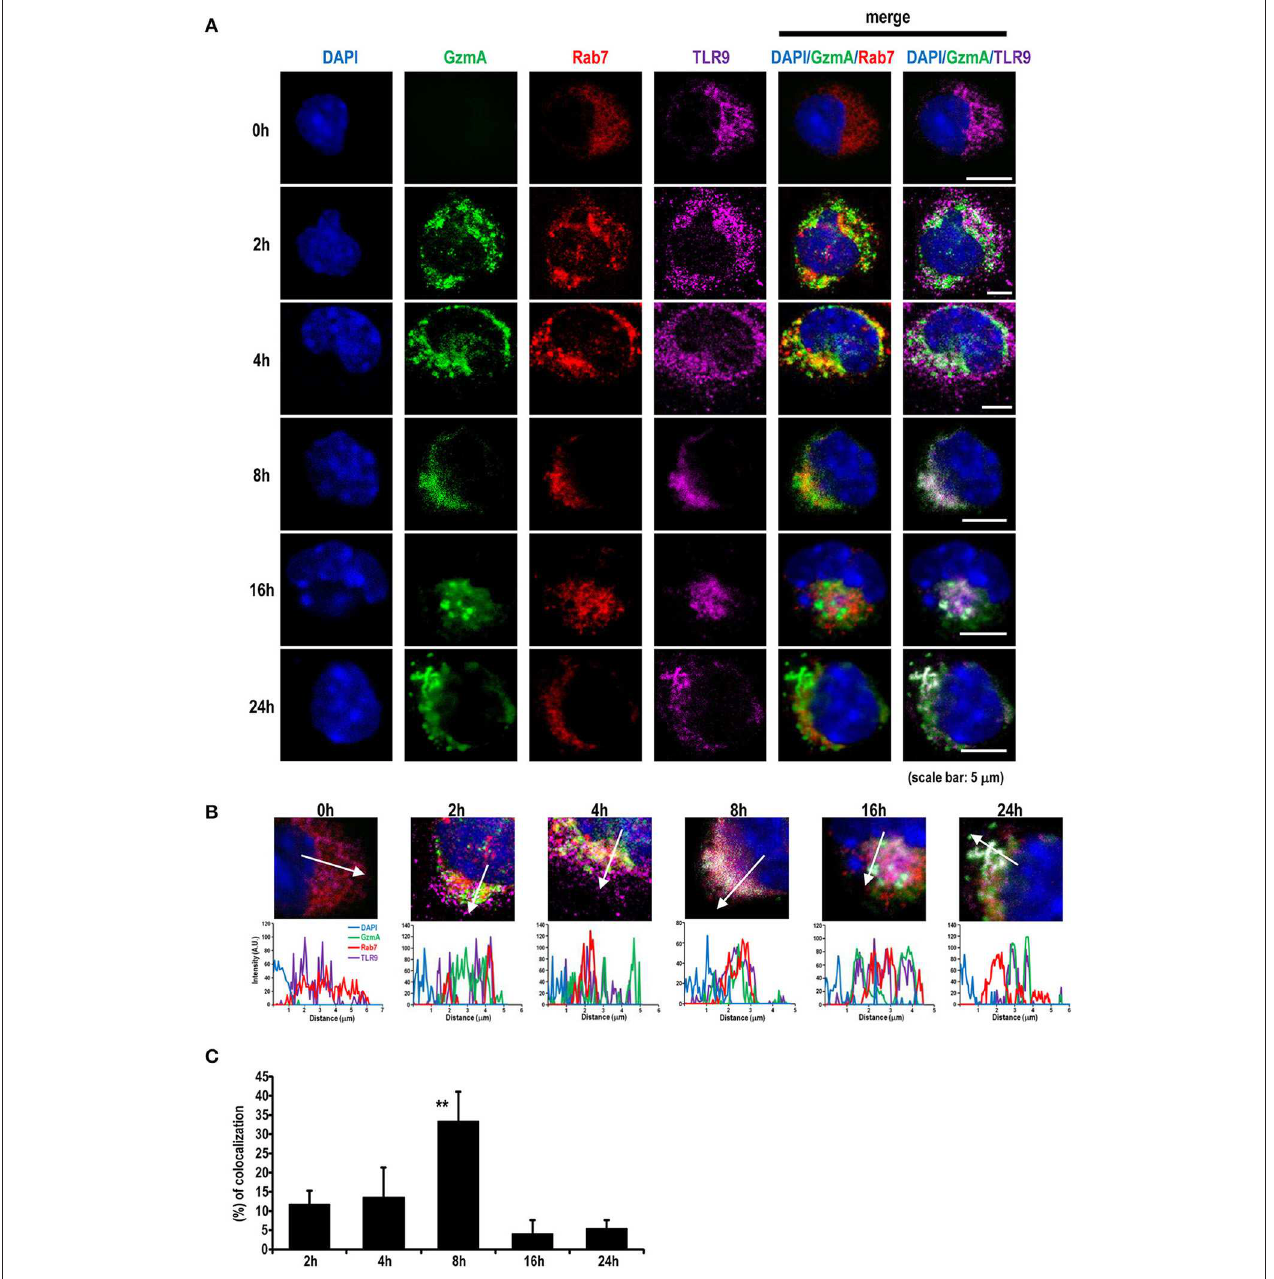
FIGURE 5 | GzmA colocalizes with TLR9 in the late endosome compartment. (A) Representative images showing localization of Alexa488-labeled GzmA (green) in pDCs. Sorted pDCs incubated with Alexa488-labeled GzmA (green) were harvested at the indicated time points after GzmA treatment and stained with anti-TLR9 (magenta) and anti-Rab7 (red) antibodies and DAPI (blue). Scale bars, 5 µ m. (B,C) Intensity line profiles from magnified images were assessed. Line scans represent variation in red, green, and magenta fluorescence intensity along the line denoted by an arrow and then the colocalization was quantified as described in the text (mean ± SEM, n = 5–9). ** p < 0.01 (one-way ANOVA test with Tukey’s post-hoc